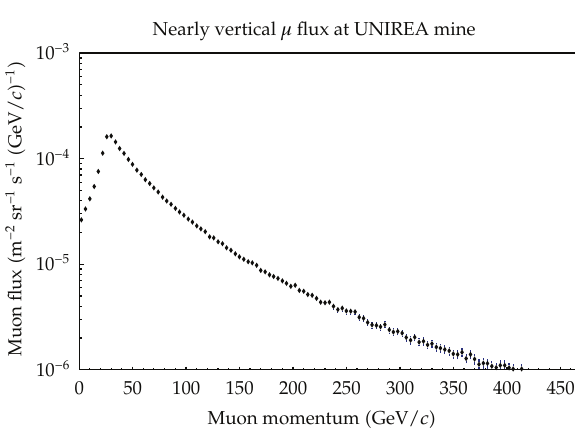
Figure 5: Flux of nearly vertical muons (cid:3) θ ≤ 10 ◦ (cid:4) at UNIREA mine.